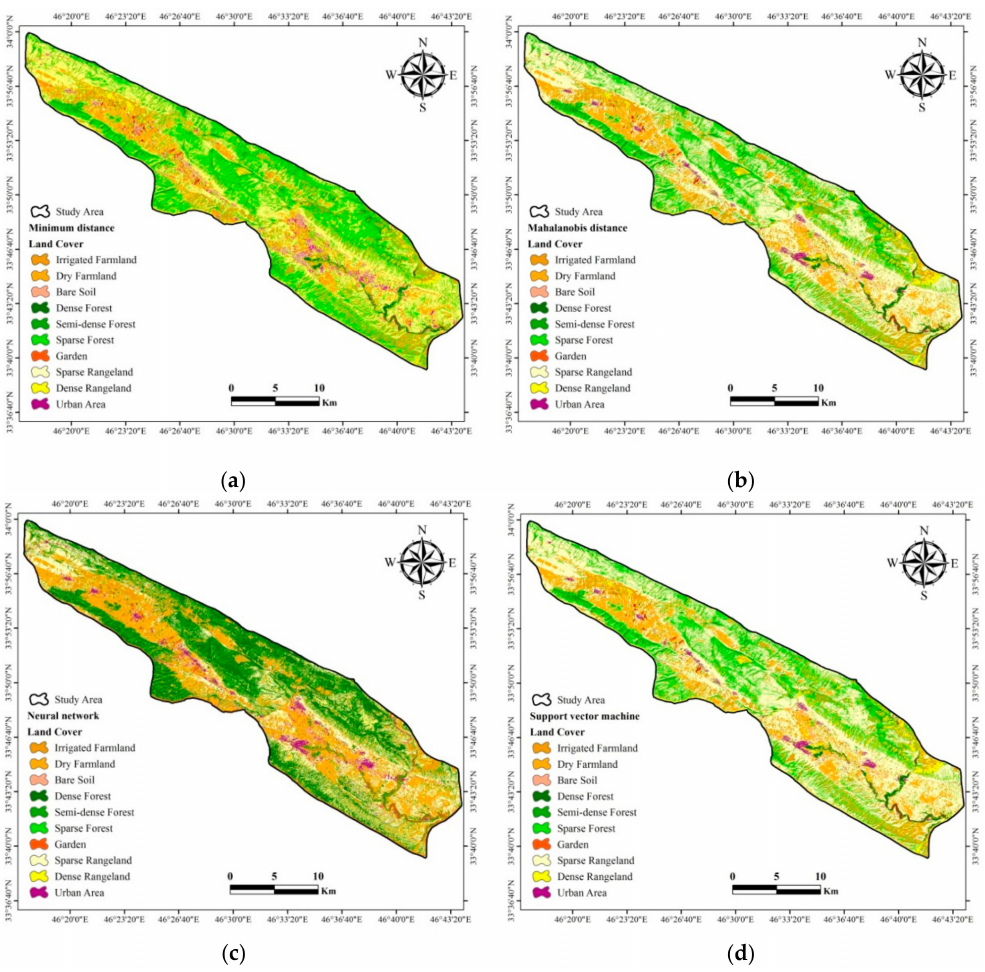
Figure 9. The supervised classification of Sentinel-2 image using di ff erent algorithms. ( a ) Minimum distance. ( b ) Mahalanobis distance. ( c ) Neural network. ( d ) Support vector